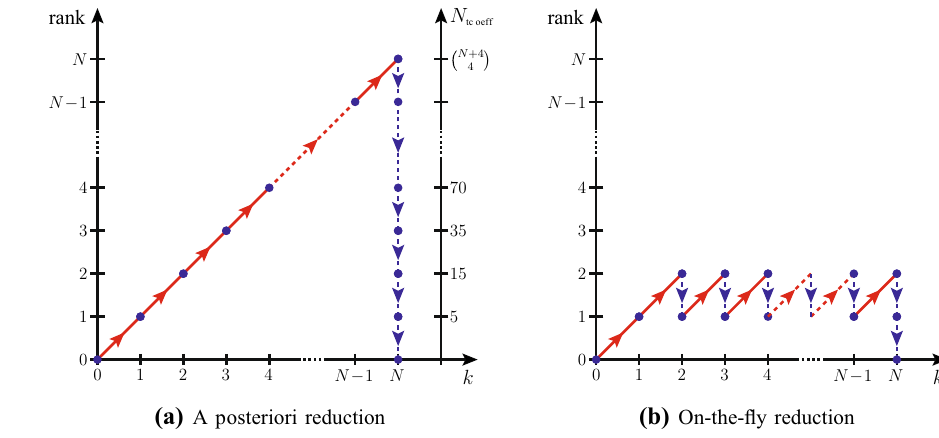
Fig. 1 Evolution of the tensor rank and the number of open-loop tensor coefficients (right vertical axis) as a function of the number k of dressed segments during the open-loop recursion. The red diagonal lines illustrate the dressing steps, and the blue vertical lines the reduction